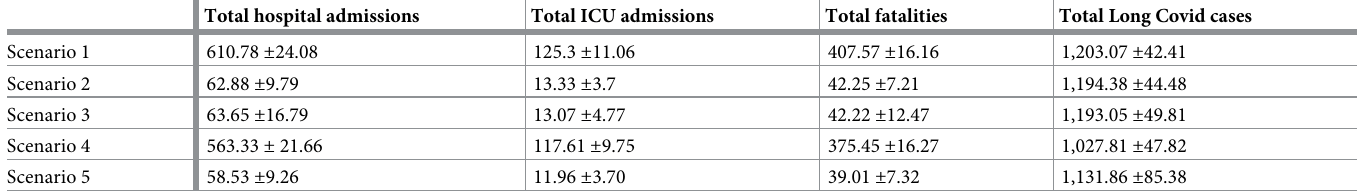
Table 3. Mean ( ± sd) model outputs for healthcare related endpoints over the lifetime of the simulated